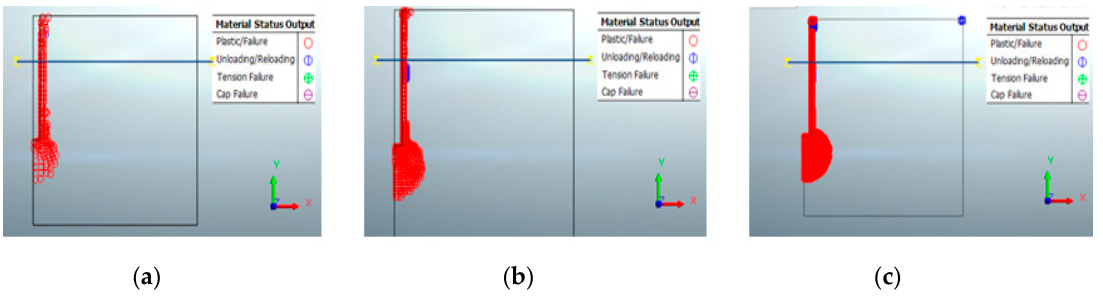
Figure 5. The shape of the formed plastic points at the last load increment of the three finite element models with varying sizes of mesh. ( a ) Coarse mesh, ( b ) medium mesh, ( c ) fine mesh.